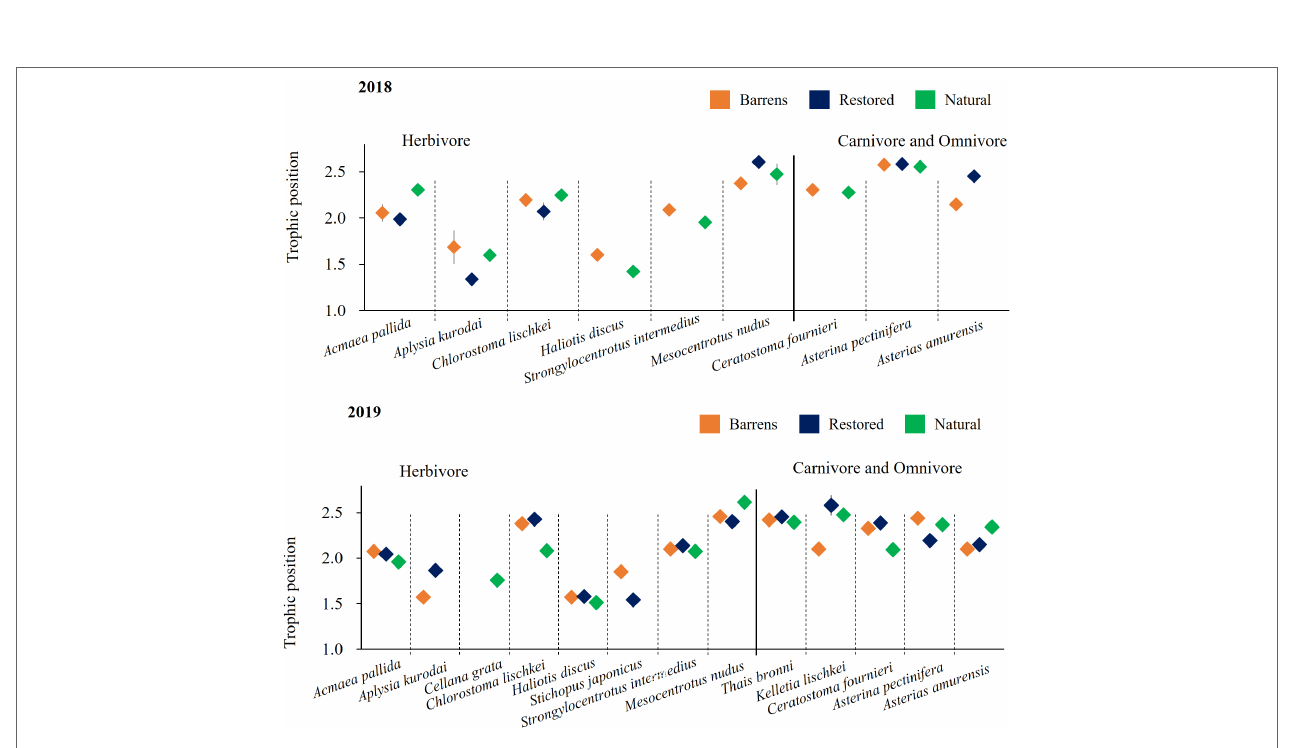
FIGURE 5 | Trophic positions of consumers at each year and site (represented by colored squares). The symbol and the vertical error bar represent the average and the standard error of each sample, respectively ( n =